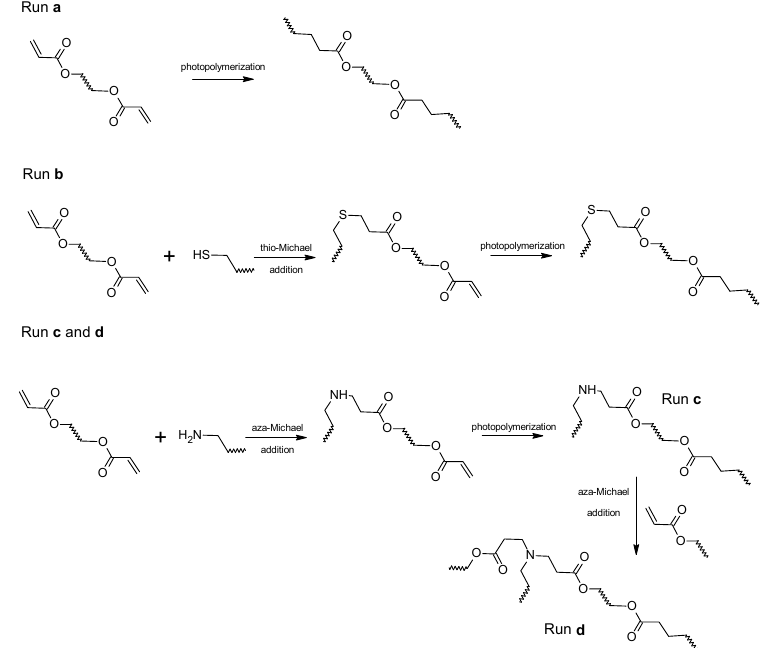
Scheme 1. Mechanisms of reactions involved in the fabrication of the four samples.